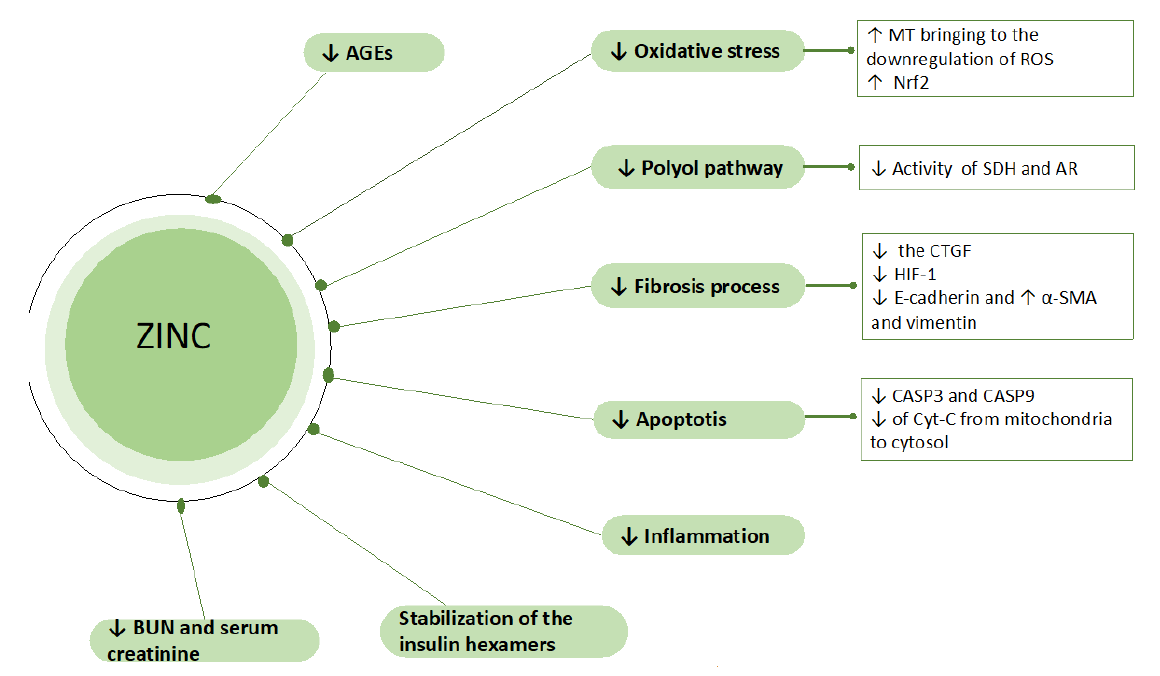
Figure 1. Zinc-related mechanisms in body homeostasis. AR, aldose reductase; CASP3, caspase 3; CASP9, caspase 9; CTGF, connective tissue growth factor; Cys-C, C-Cytochrome; HIF1, hypoxia inducible factor; MT, metallothionine; Nrf2, nuclear factor-erythroid 2-related factor 2; ROS, reactive oxygen species; SDH, sorbitol dehydrogenase; α-SMA, α-smooth muscle .